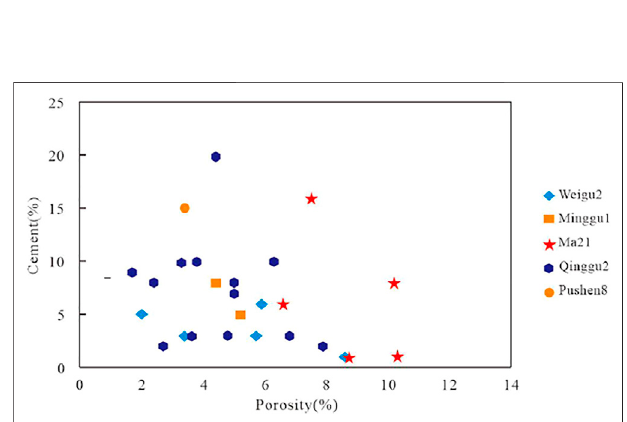
FIGURE 12 | Relationships between porosity levels and cementcontent levels of the Upper Paleozoic reservoirs in the Dongpu Depression.